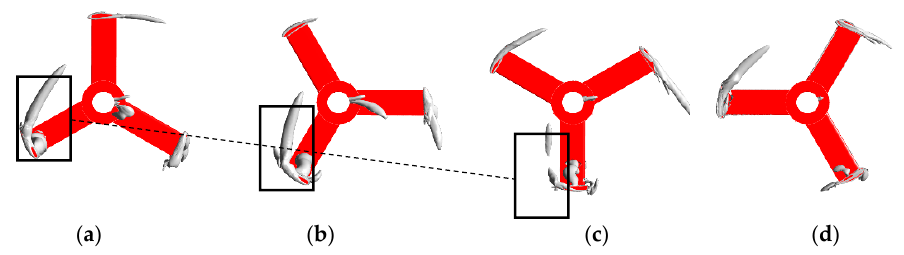
Figure 9. Time evolution of blade tip vortex ( λ = 1.5). ( a ) 120°; ( b ) 150°; ( c ) 180°; and ( d ) 210°.